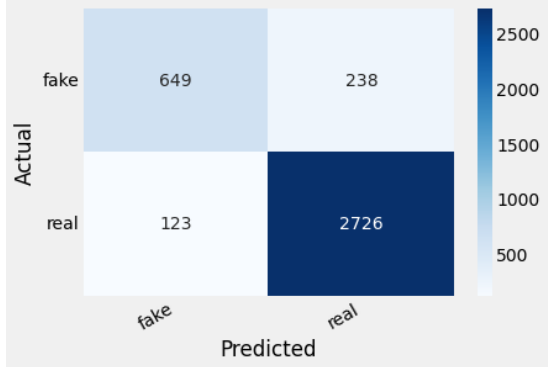
Figure 9. Confusion Matrix of BERT base -BiGRU-CNN-ATT in GossipCop.